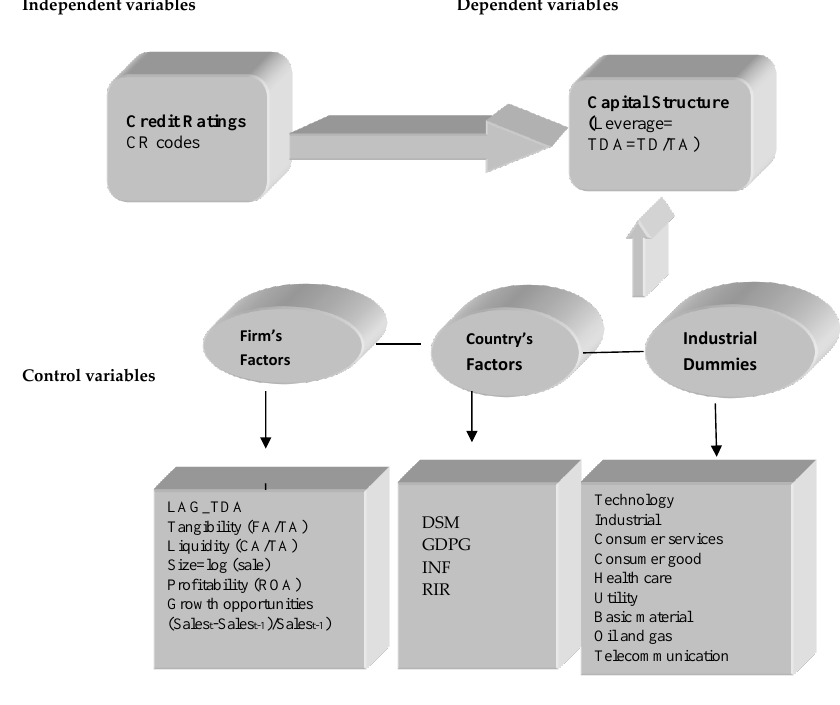
Figure 1. Conceptual